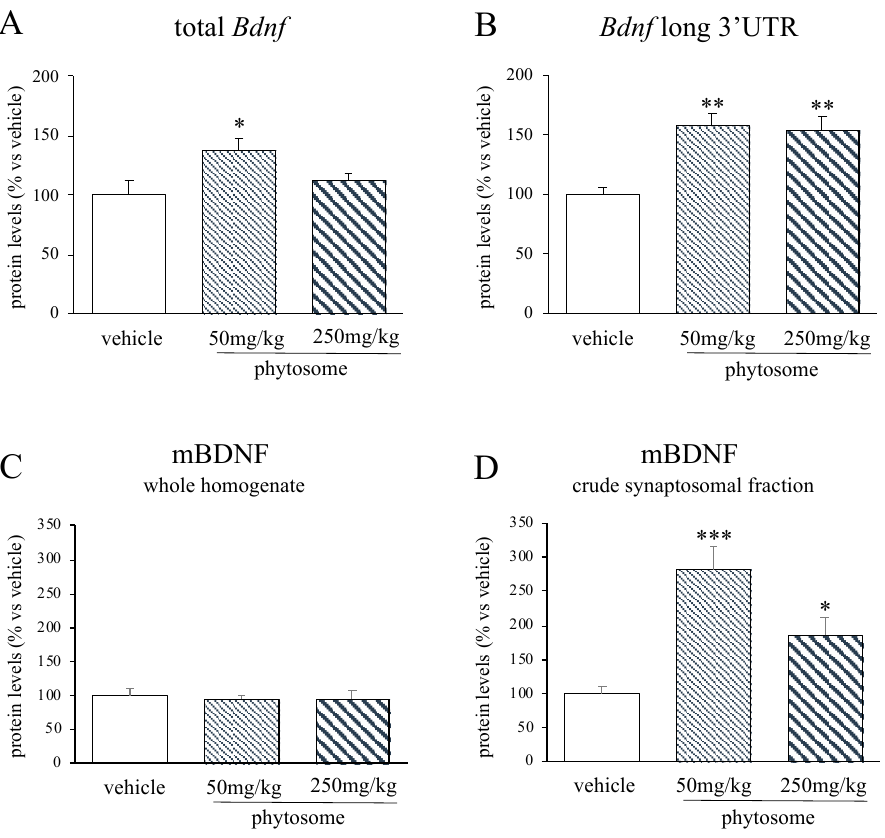
Figure 2. Analyses of total Bdnf , ( A ) Bdnf long 3 ′ UTR ( B ) mRNA levels and mBDNF protein levels in the whole homogenate ( C ) and crude synaptosomal fraction ( D ) of the PFC of rats treated with phytosome 50 mg/kg or 250 mg/kg. Data are expressed as percent change of vehicle treated rats and are represented in the histograms graphs as mean ± SEM of 5–6 independent determinations. * p < 0.05, ** p < 0.01, *** p < 0.001 vs. vehicle; one-way ANOVA with Fisher’s PLSD.